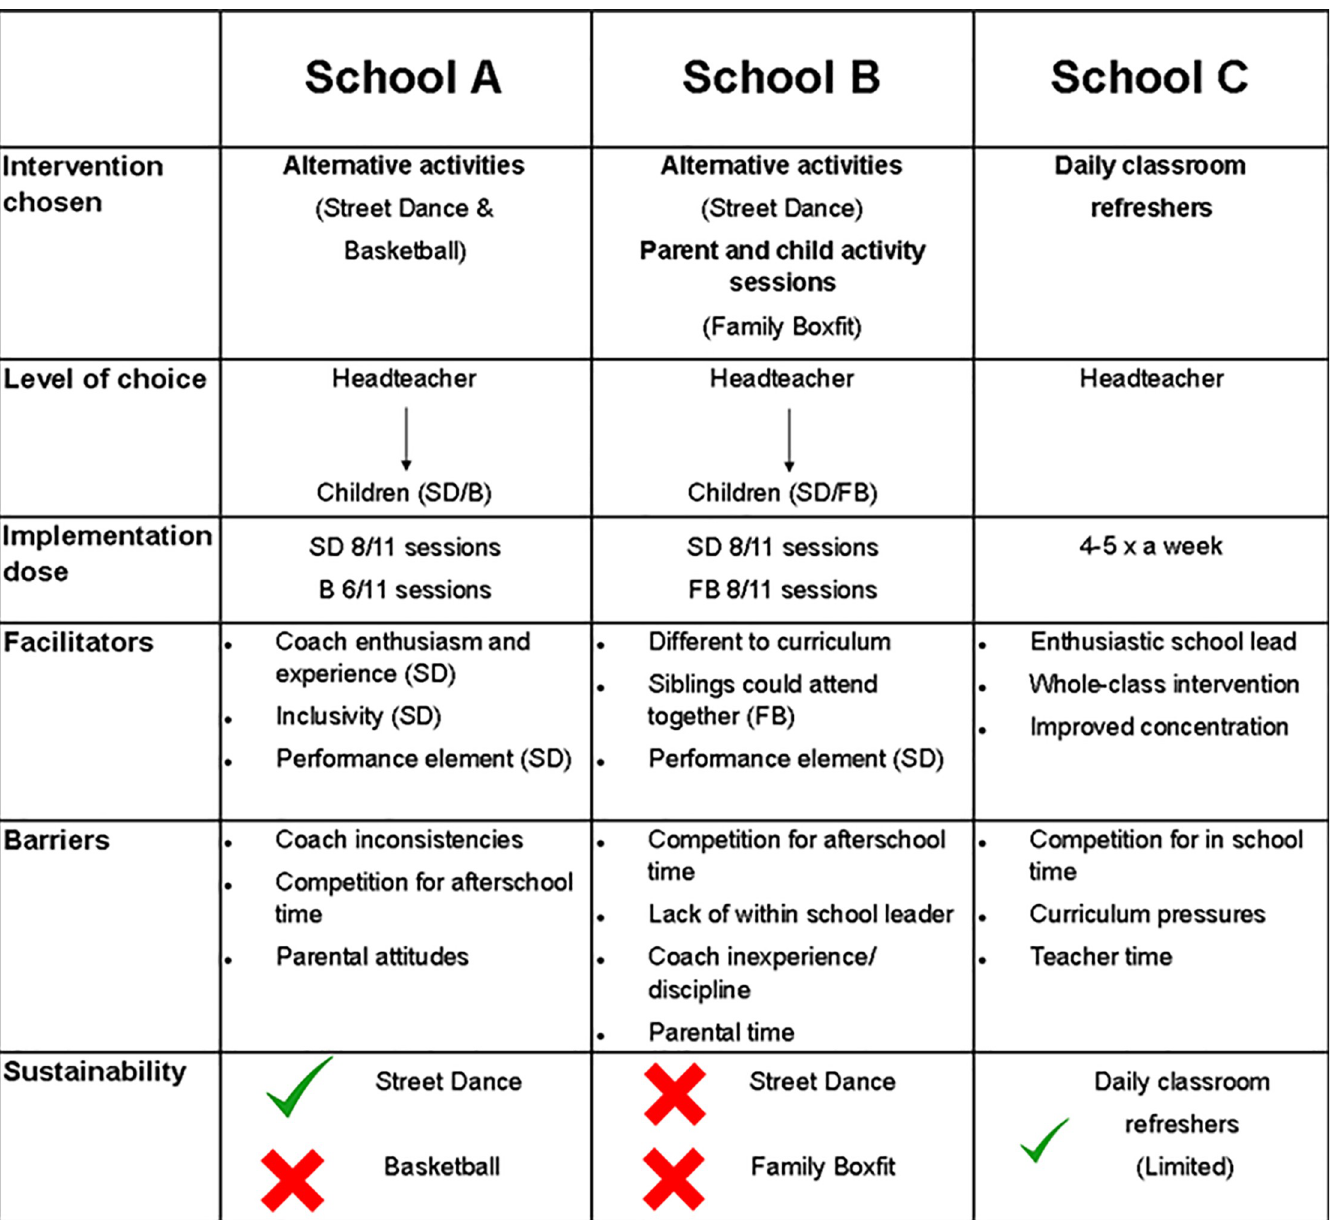
Fig 2. CLASP implementation schematic. Legend: The down arrow shows where the headteacher, teacher and children had a choice in the intervention, whereas for the school C, the headteacher made the choice (SD = Street Dance, B = Basketball, FB = Family Boxfit).